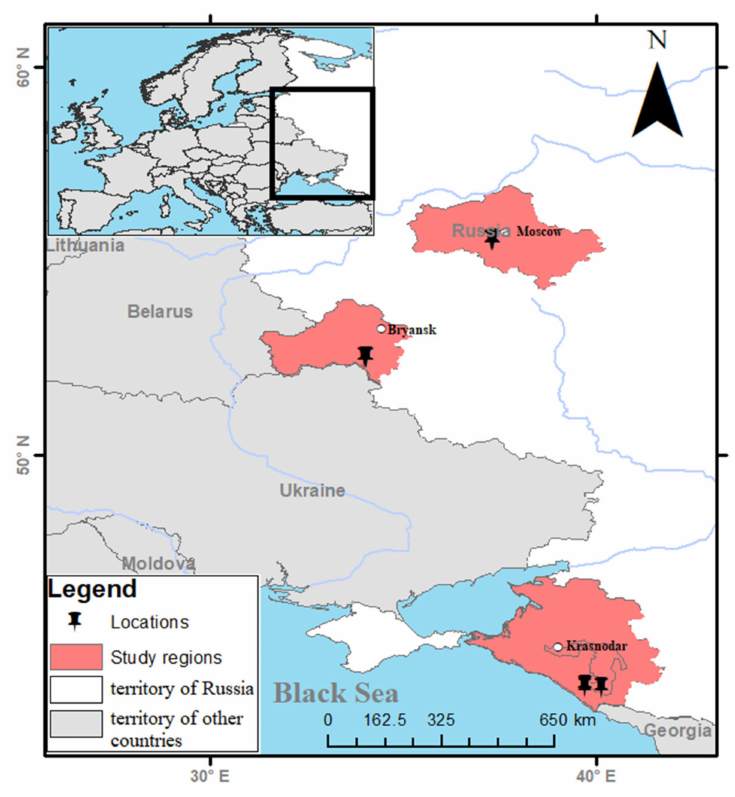
Figure 1. Location of the study